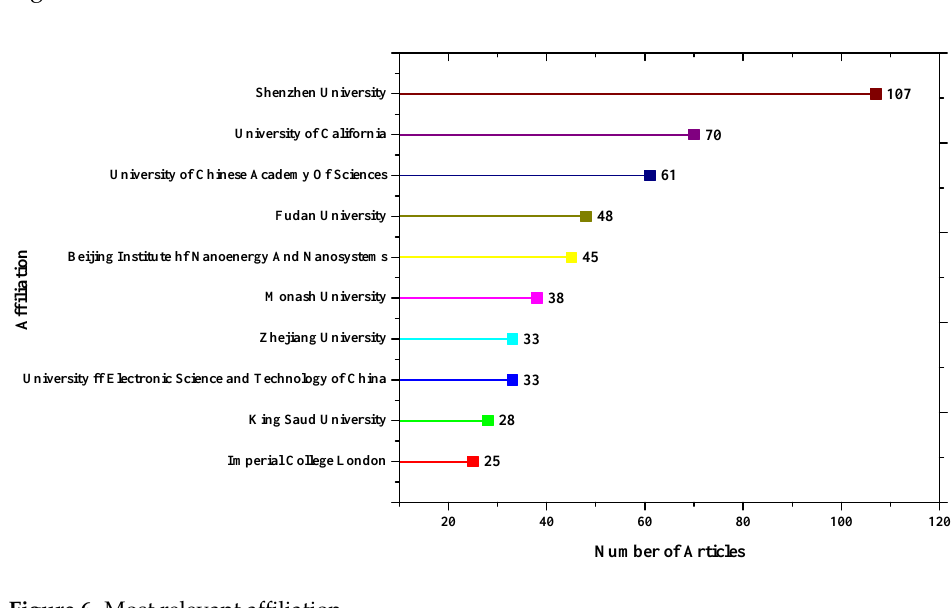
Figure 6. Most relevant